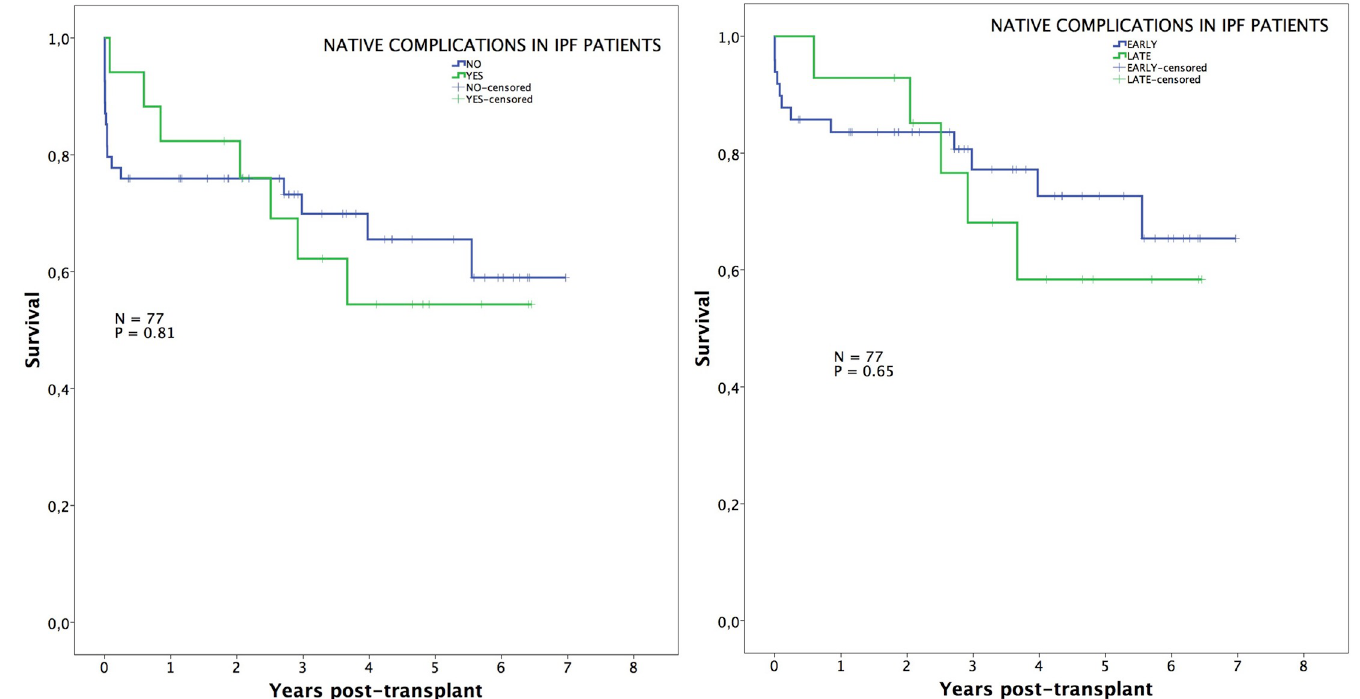
Fig 2. Survival in IPF patients. Post-transplant survival of IPF patients comparing those with or without native lung complications (left), and those with early or late native lung complications (right).